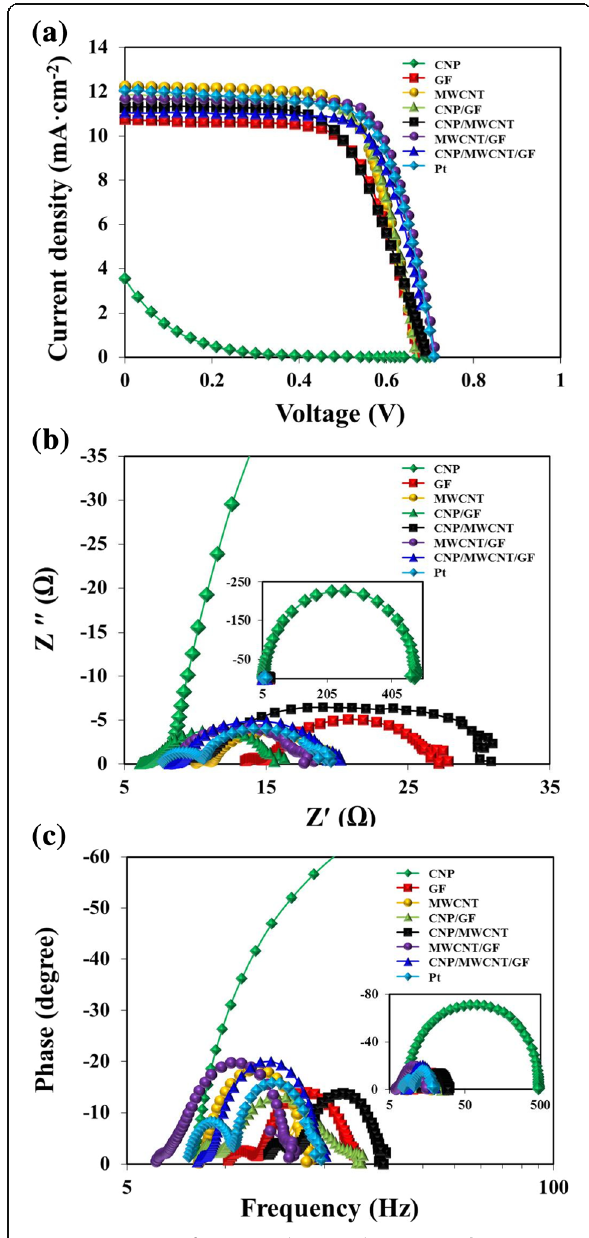
Fig. 7 Comparison of a current density-voltage curves, b Nyquist plots, and c Bode plots for the DSSCs composed of various carbon materials- and Pt-based